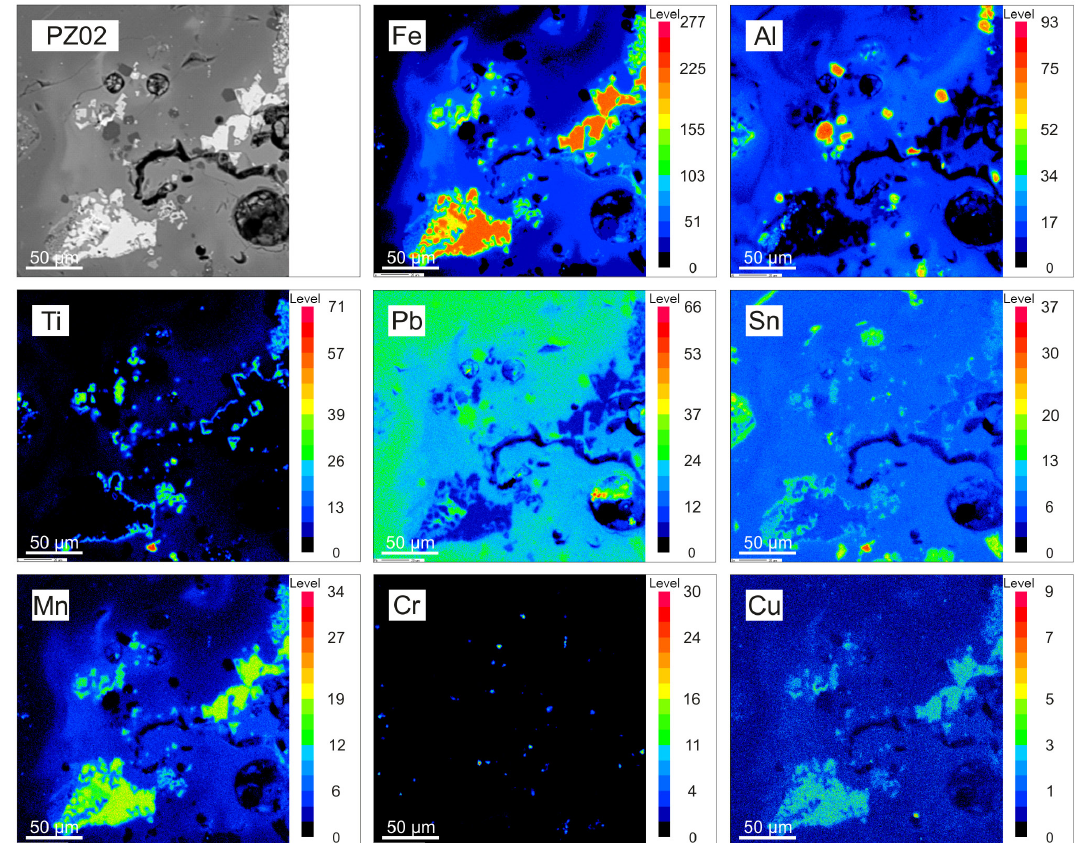
Figure 2. IHWI BA WDX maps. BA grain rich in metallic inclusions (Fe-Mn-Ti